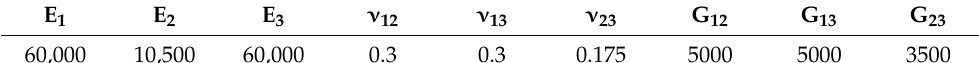
Table 5. Properties of the quasi-isotropic carbon fibre laminate used in the reference component simulation. All moduli are in MPa and Poisson’s ratios are dimensionless. The coordinate system considered is the local one.